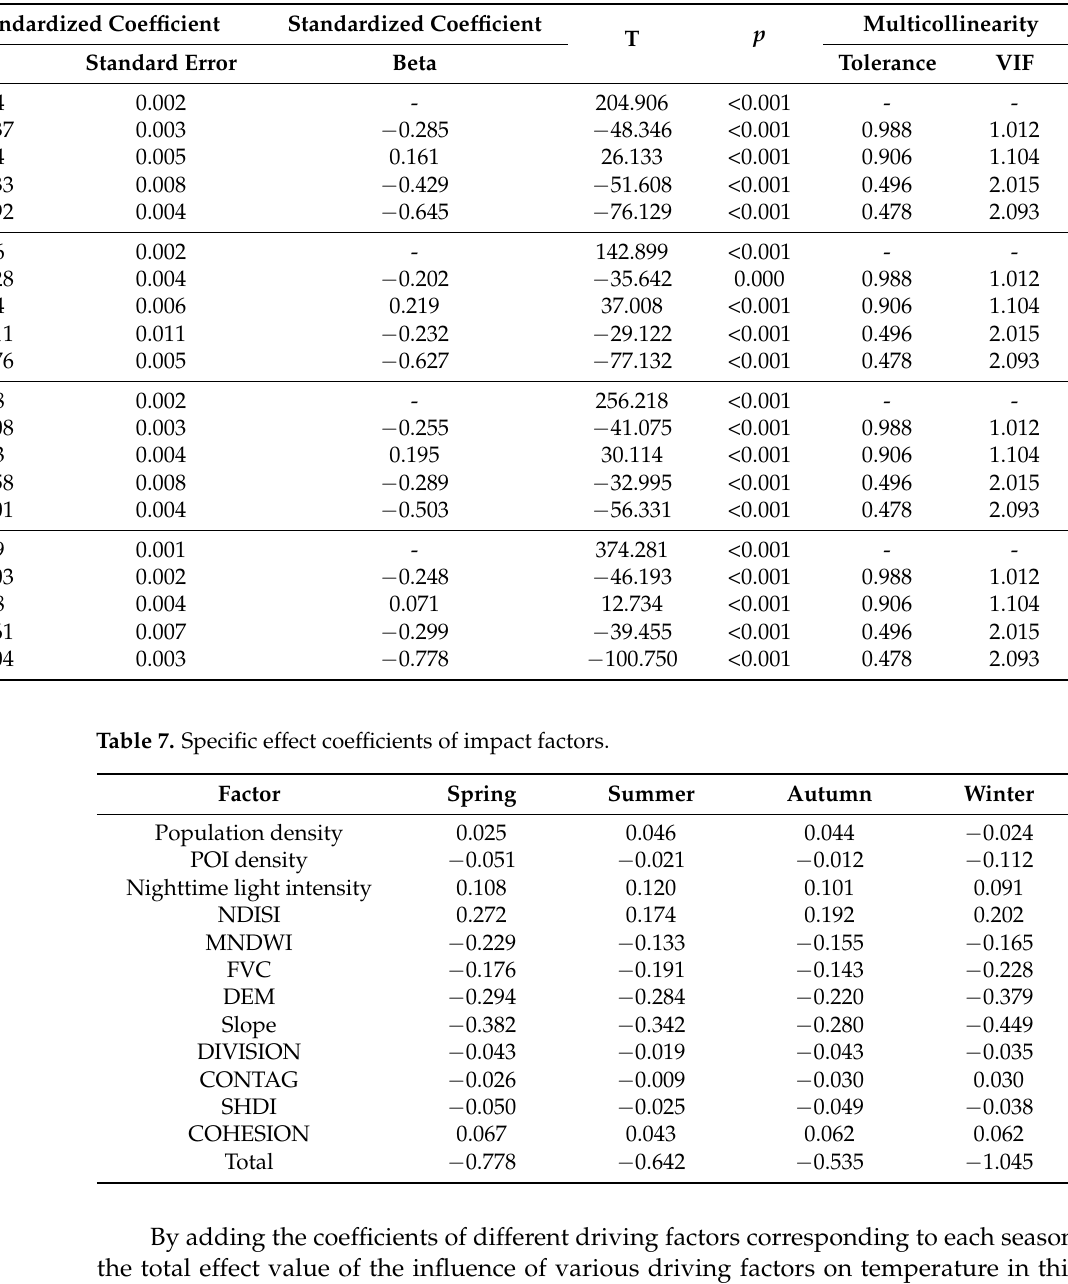
Table 6. Regression coefficients and test results.